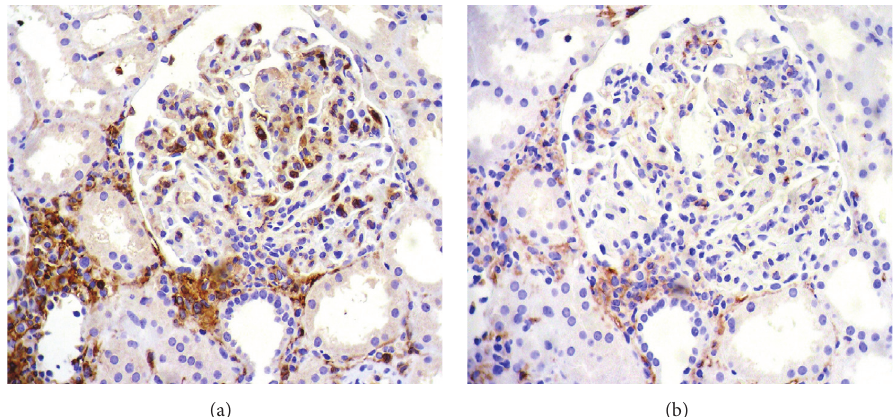
Figure 1: (a) Immunohistochemistry for CD16: abundant CD16 + cells in the glomerular tuft; these cells are also evidenced in the interstitium. (b) Immunohistochemistry for CD14: a glomerulus with few positive CD14 + cells. There are also some CD14 + cells in the interstitium. Both images, × 400.